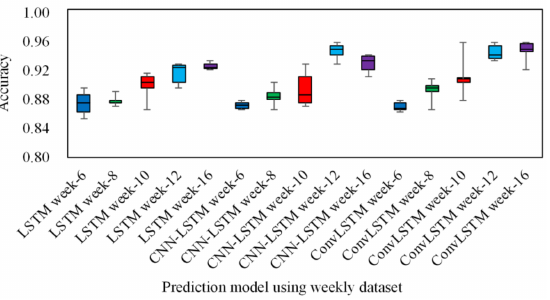
Figure 4. Boxplot of the 10-fold cross-validation of validation accuracy. Table 4. Summary of the early prediction of model performance using a six-week-wise data set. Feature Extraction Classifier Accuracy Precision